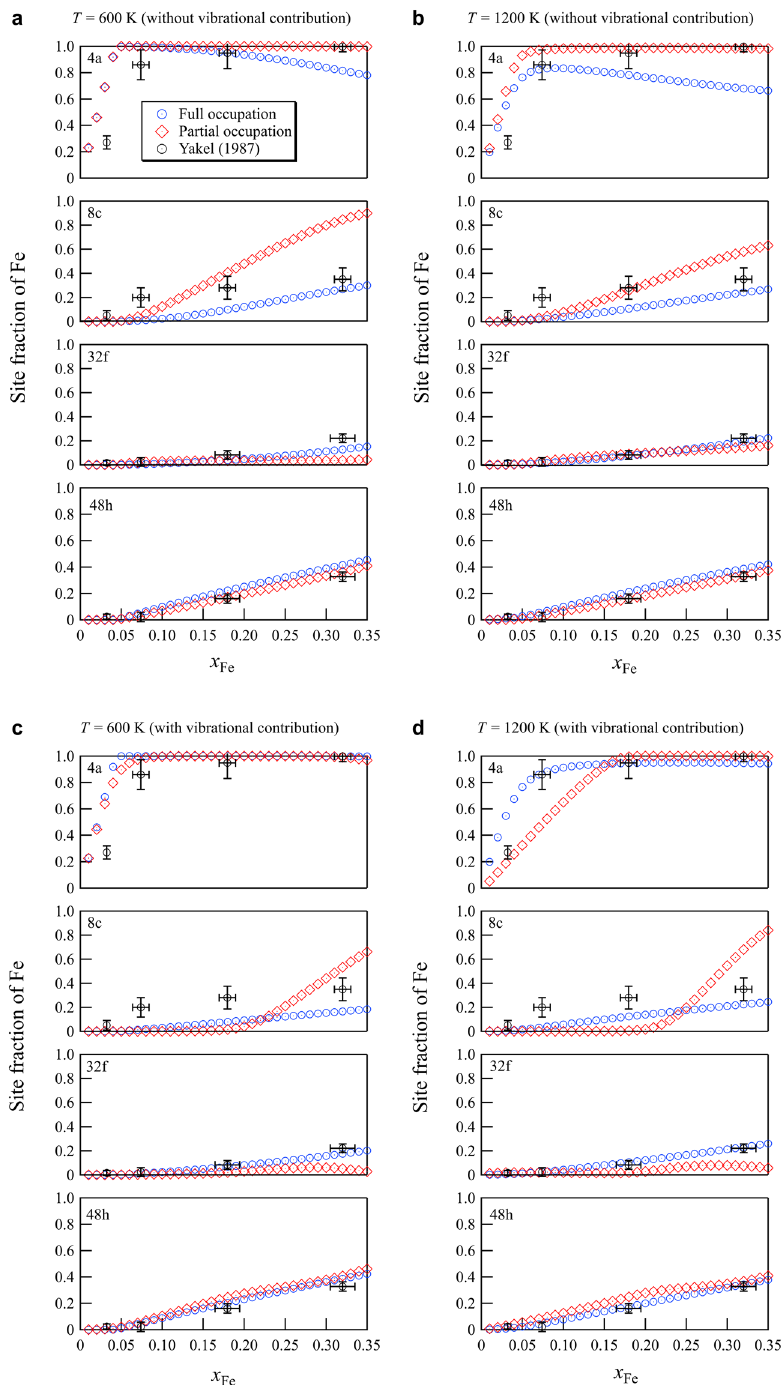
Figure 5. Iron site occupation on the inequivalent metal sites of γ -Cr 23 − x Fe x C 6 ( x = 0–3) as a function of x Fe , ( a , b ) without and ( c , d ) with vibrational effects at T = 600 K and T = 1200 K. The experimental data with error bars are plotted also for comparison 32